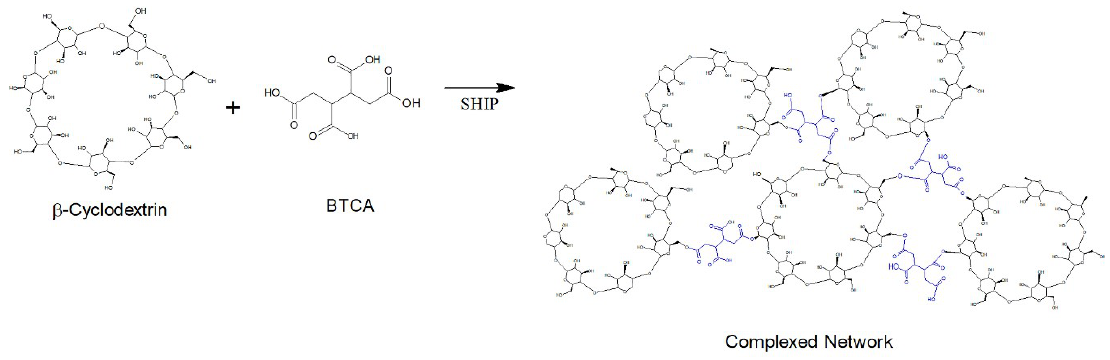
Figure 2. Mitochondrial metabolic enzymes activity in diabetic rat heart and effect of resveratrol Figure 2. Complex network polymer formed between β CD and